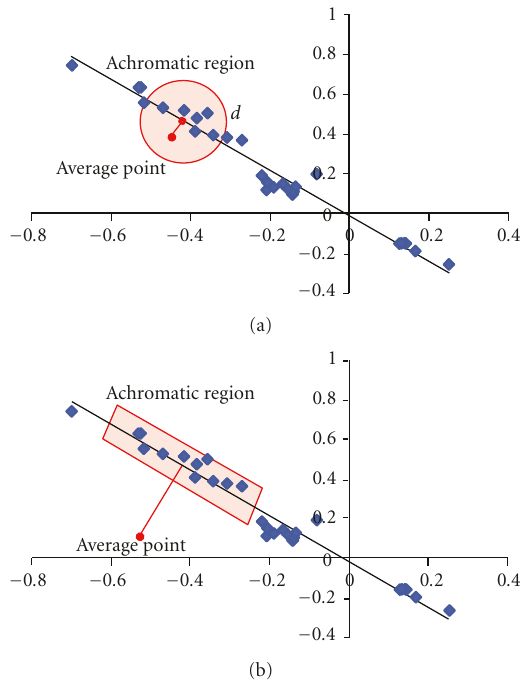
Figure 6: Restricted achromatic region: (a) average point inside the achromatic region and (b) average point outside the achromatic